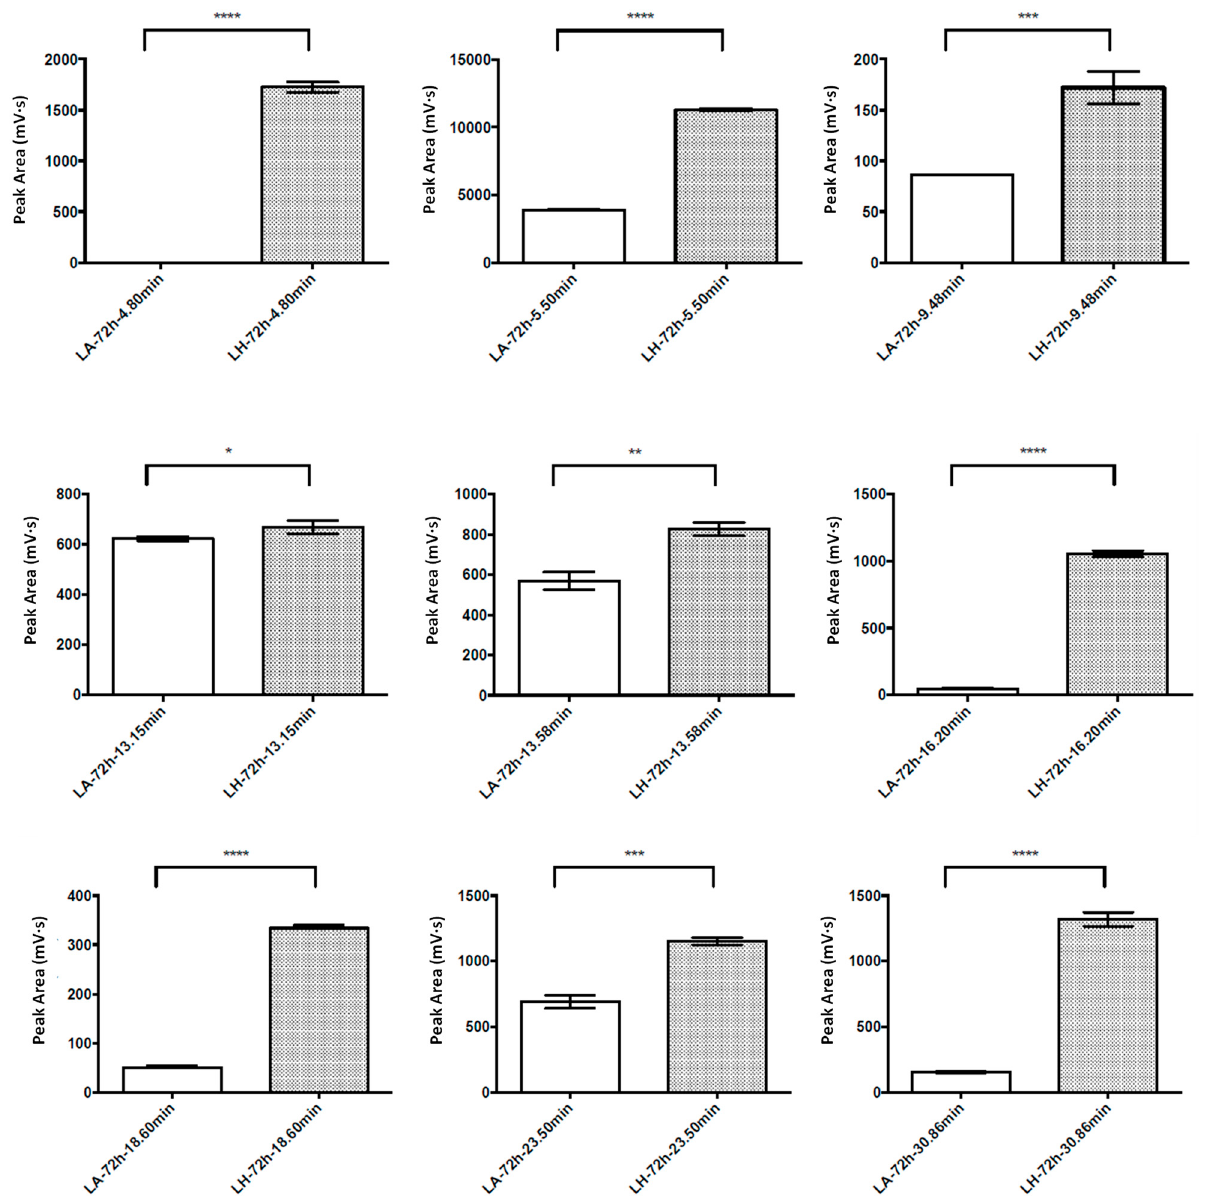
Figure 2. Graphical representation of the comparison between L. acidophilus (LA 14) and L. helveticus (LH) activity upon 72 h fermentation, based on area values of reference peaks (measured in mV·s). Data are the mean ± standard deviation (SD) of three replicates. Data were analyzed by a Student’s unpaired t -test. **** p < 0.0001, *** p < 0.001, ** p < 0.01, * p < 0.05. Table 1. Comparison of the antioxidant (by ABTS and FRAP assays) and ACEi activities of hydrol- ysates after 12 h fermentation with L. acidophilus and L. helveticus . Values are expressed as mean values ± standard deviation (SD), n = 2.